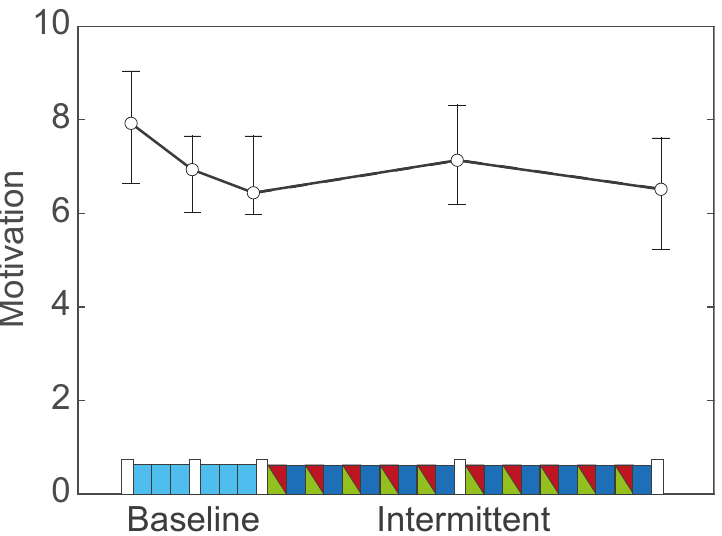
Fig 4. Motivation. Median of motivation scores across participants over time. Error bars indicate interquartile range. The blocks along the x-axis indicate the feedback context in the same format as Fig 1C. Motivation decreases during the baseline phase, increases during the first half of the intermittent phase and decreases again in the second half of the intermittent phase.